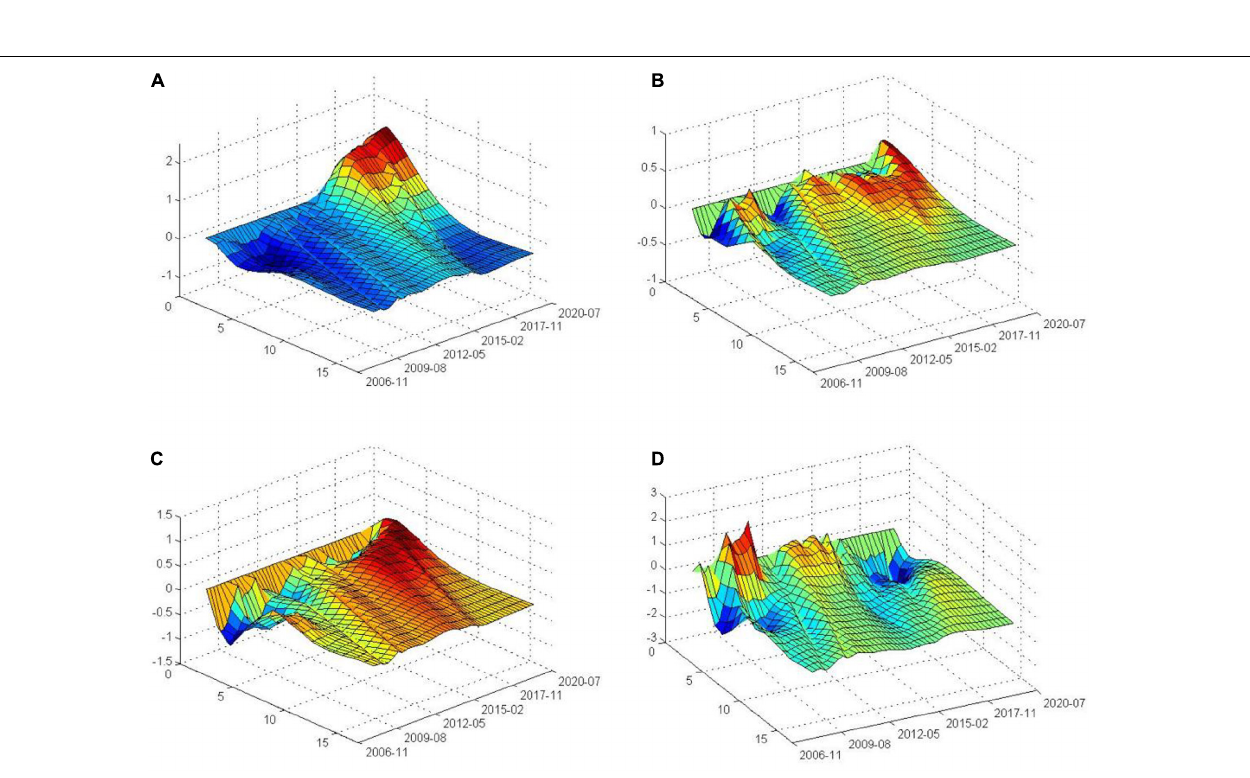
FIGURE 4 | Full sample impulse graph of the impact of carbon price on key price drivers. (A) Full sample impulse of carbon price response to oil price shocks. (B) Full sample impulse of carbon price response to gas price shocks. (C) Full sample impulse of carbon price response to electricity price shocks. (D) Full sample impulse of carbon price response to stock price